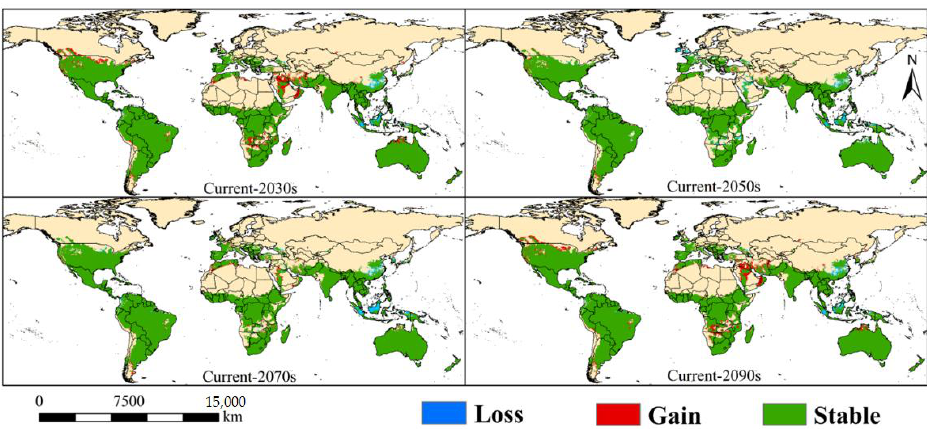
Figure 6. Future potential distributions of Anthonomus grandis based on the BCC-CSM2-MR model: SSP5-85, 2030s; SSP5-85, 2050s; SSP5-85, 2070s; SSP5-85, 2090s.